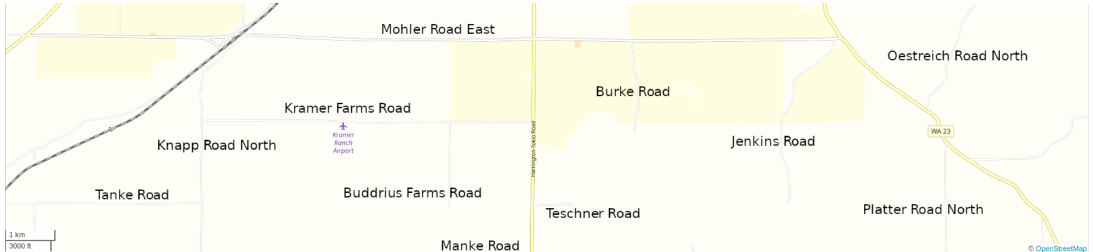
Figure 8. Cluster of streets with names mainly from German speaking origin. The cluster is located in Lincoln County in the state of Washington. The map has been created using OpenStreetMap (www.osm.org). Table 2. Numbers of the US american census data of 2014 for the state of Washington (WA), Lincoln County and its county seat Davenport for the total population and inhabitants of German origin